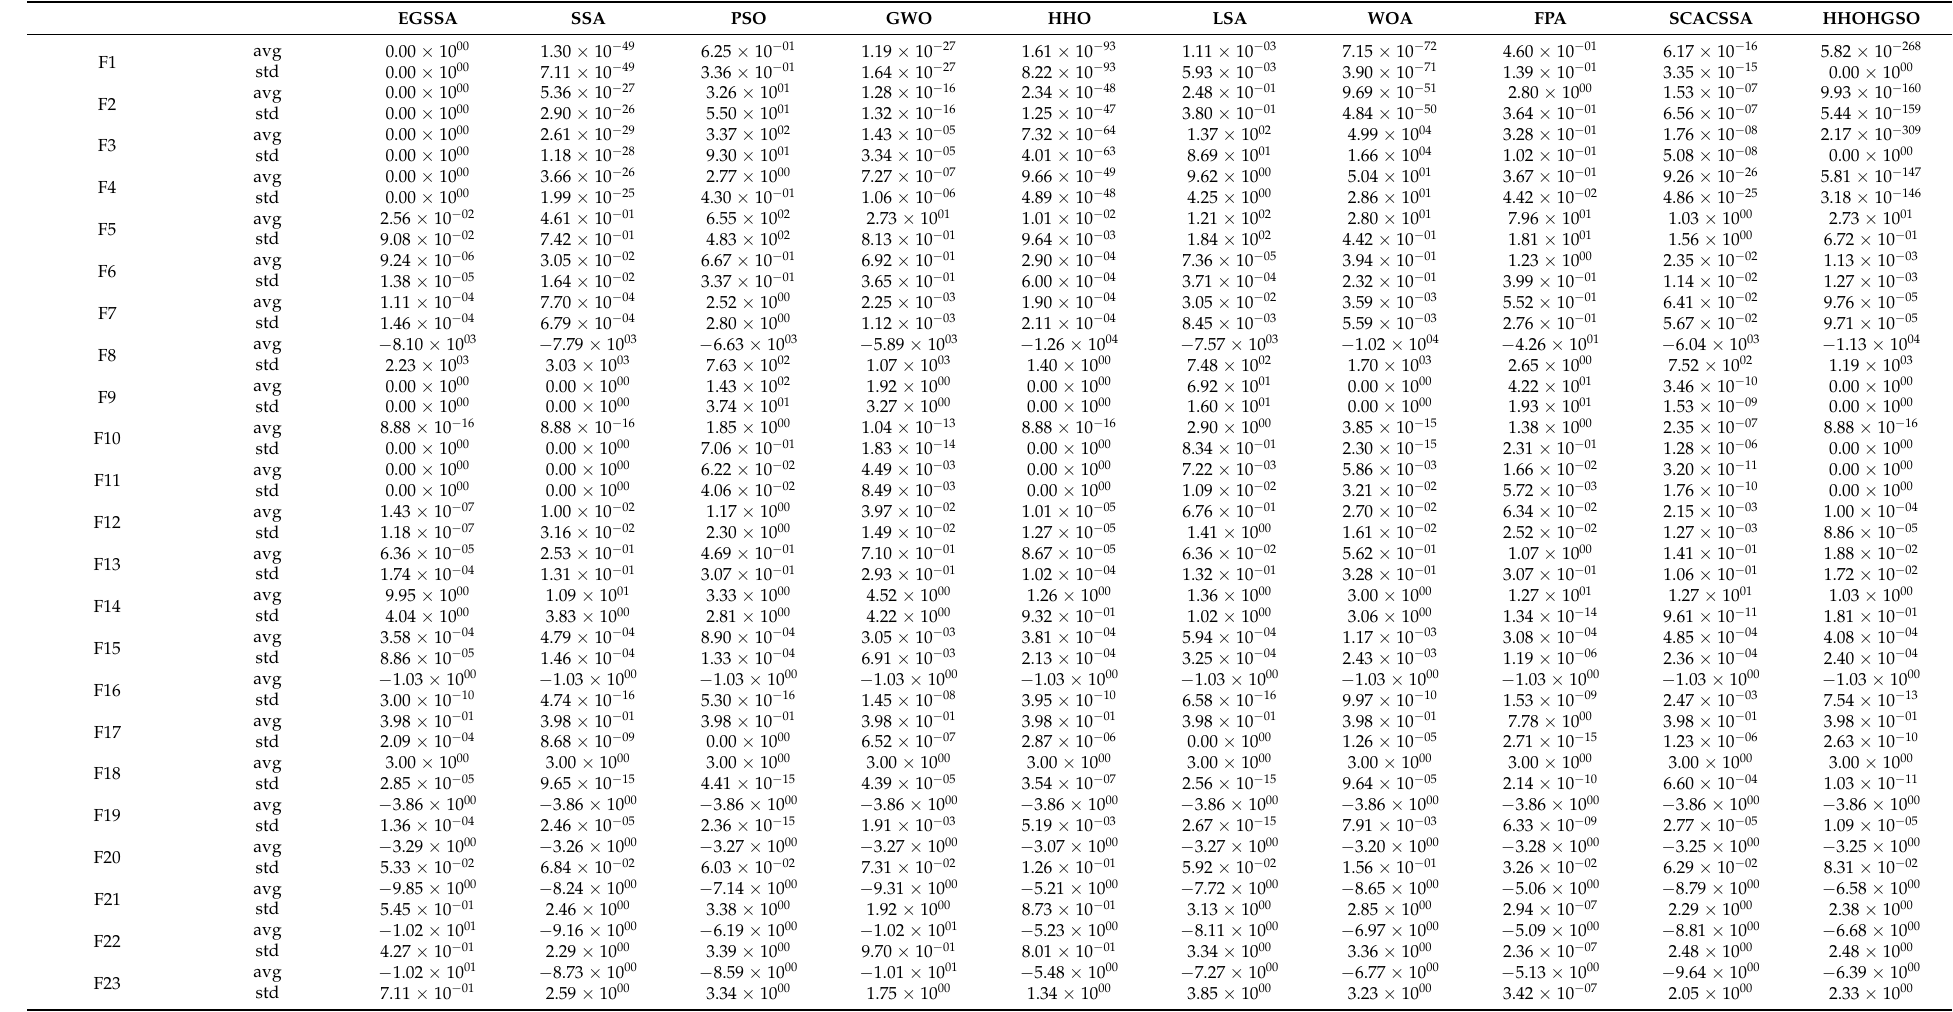
Table 4. The results based on the 23 classical benchmark functions (retaining two decimal